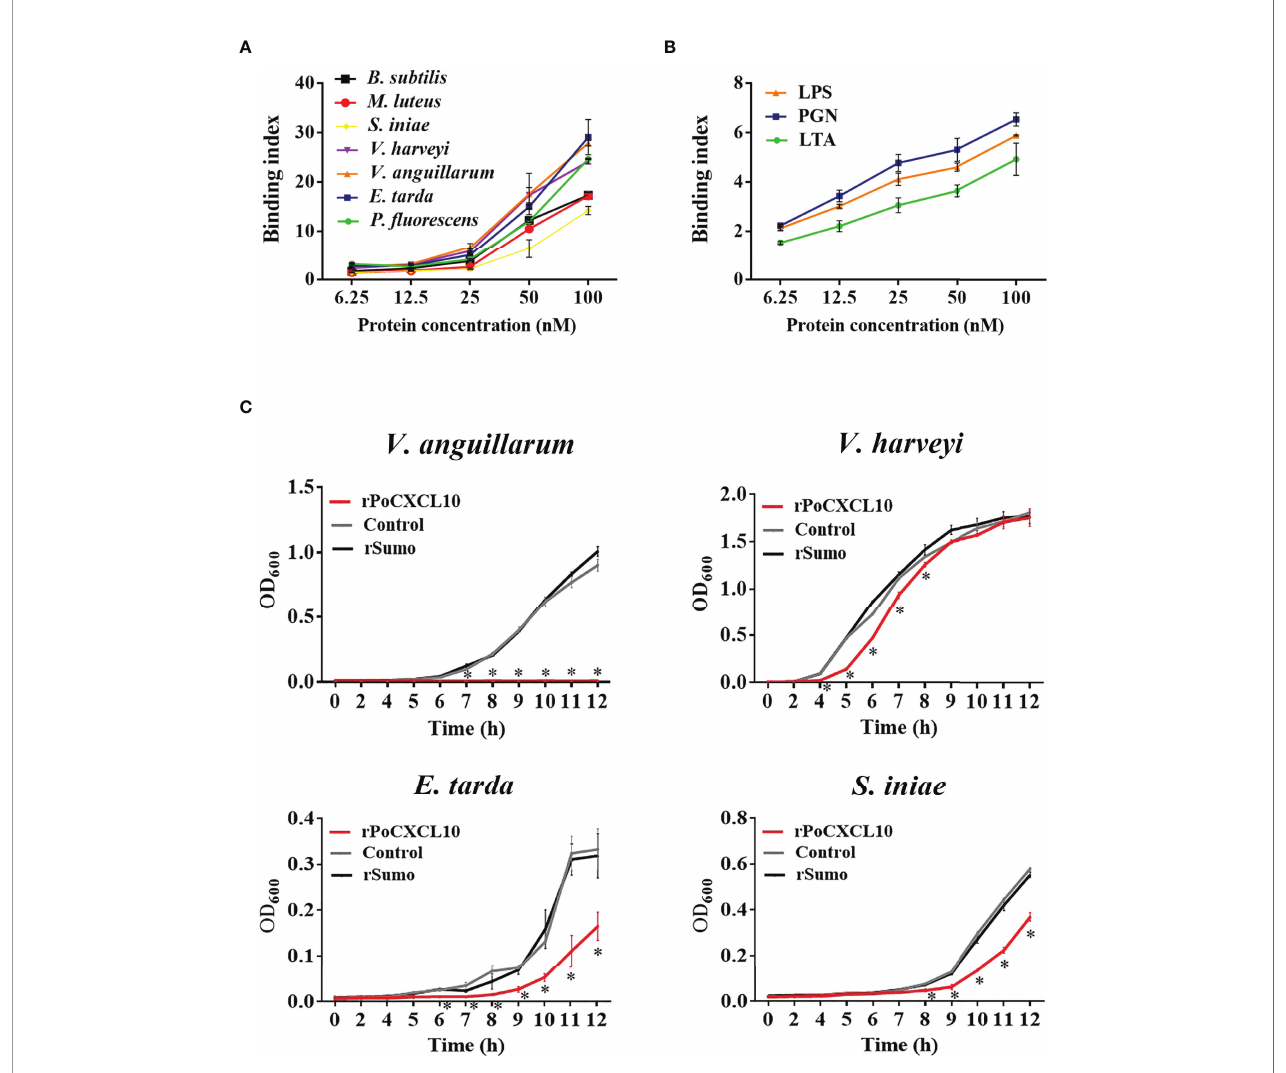
FIGURE 2 | Interaction of rPoCXCL10 with bacterial components and its effect on bacterial growth. (A) Bacillus subtilis , Micrococcus luteus , Streptococcus iniae , Vibrio anguillarum , Vibrio harveyi , Edwardsiella tarda , and Pseudomonas fl uorescens were incubated with or without (control) rPoCXCL10 at various concentrations (6.25 nM, 12.5 nM, 25 nM, 50 nM, or 100 nM). Bacteria-bound protein was detected by ELISA. (B) lipopolysaccharide (LPS), peptidoglycan (PGN) and lipoteichoic acid (LTA) were incubated with or without (control) rPoCXCL10 (6.25 nM, 12.5 nM, 25 nM, 50 nM, or 100 nM), the bound protein was determined by ELISA. (C) V. anguillarum , V. harveyi , E. tarda , and S. iniae were cultured in the presence or absence (control) of 4 m M rPoCXCL10 or 4 m M rSumo, and bacterial growth at different time points was determined by measuring absorbance at OD 600 . Values are the means of triplicate experiments and shown as means ± SD, * p <